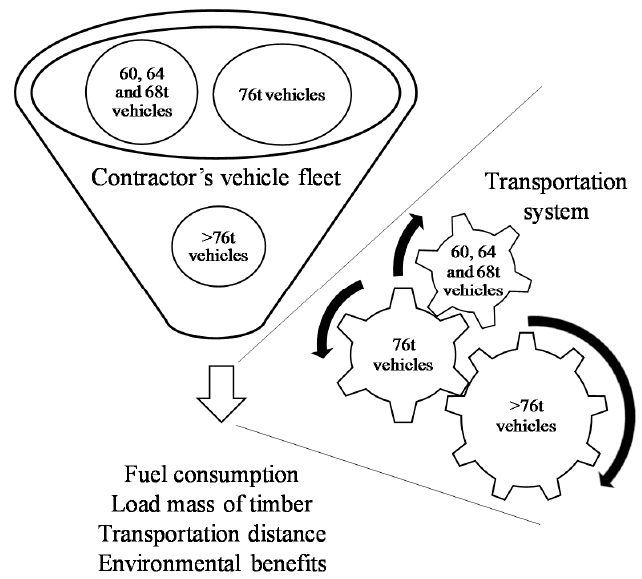
Figure 2. Energy-efficiency criteria of synchronized transportation system (STS). A high-capacity transportation (HCT) fleet of small-scale transportation company (system inputs) generates costs, emissions, revenues and services (system outputs) in STS of the wood procurement organization.